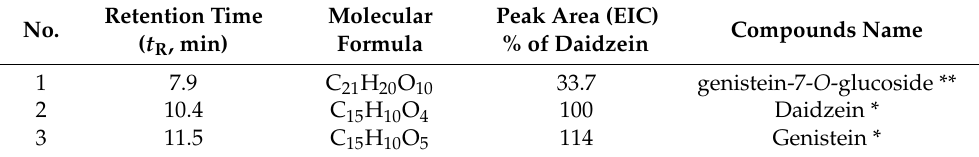
Table 4. Major isoflavones identified in the extract of soy molasses (SM) using HPLC-ESI-HRMS.